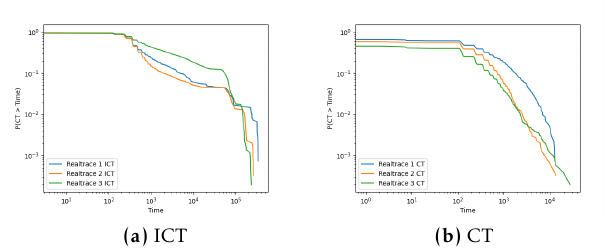
Figure 5. Contact and Inter-Contact Times of three collected real traces